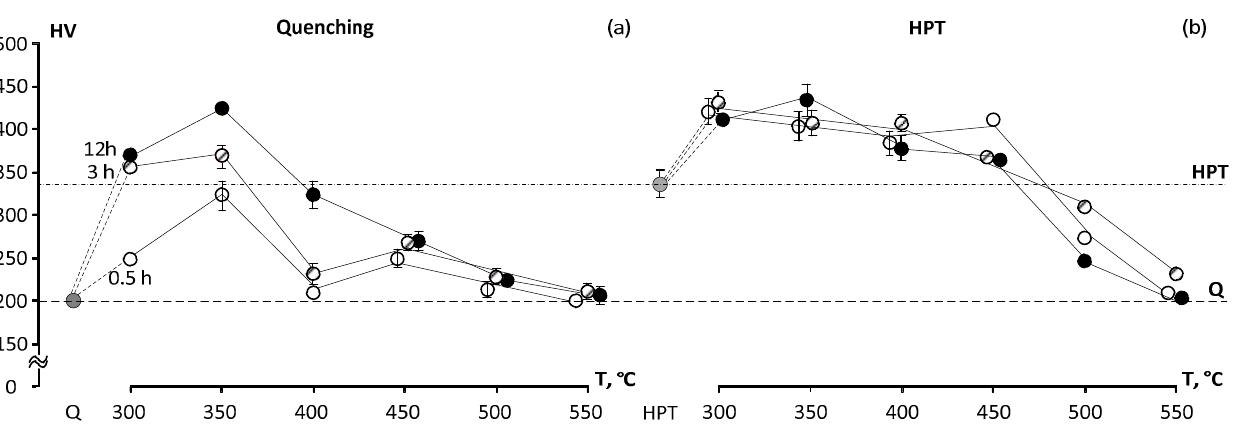
Figure 3. Volume fraction of α -phase in the Ti-18Zr-15Nb alloy depending on annealing route after ( a ) initial quenching; ( b ) initial HPT.